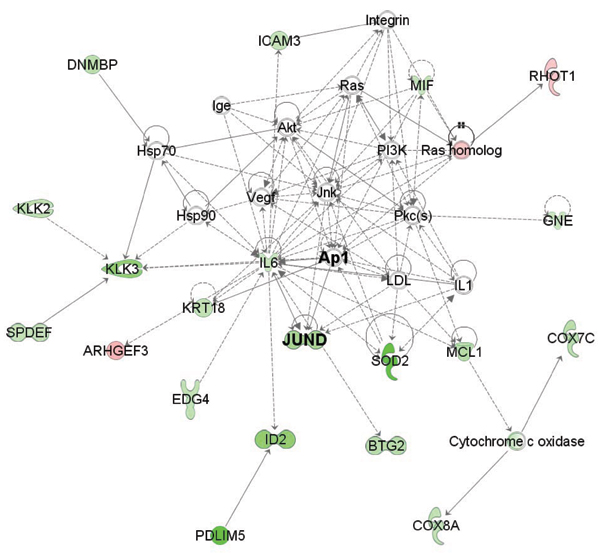
Ingenuity pathway analysis on AP-1 related gene network. Green and red nodes represent repressed and induced genes in androgen-independent prostate samples comparing androgen-dependent prostate samples, respectively.